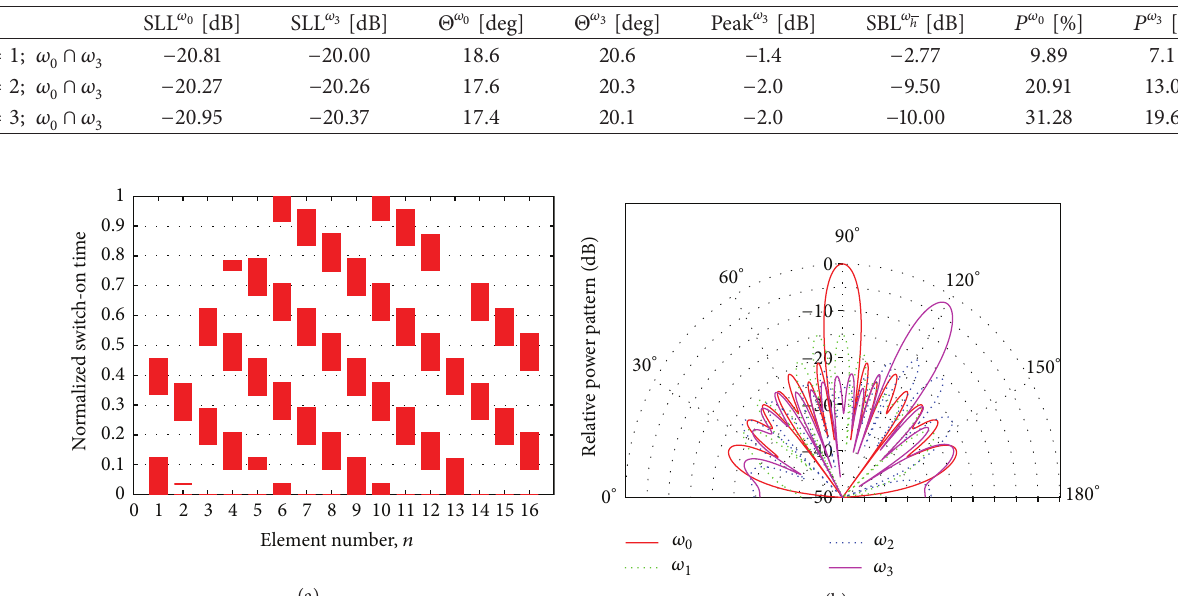
Table 2: Multibeam sum pattern synthesis at 𝜔 0 and 𝜔 3 ( 𝑁 = 16 ; 𝑑 = 𝜆/2 ; 𝜃 𝜔 0 = 90 ∘ ; 𝜃 𝜔 3 = 120 ∘ ) and pattern features for 𝑄 = 1 , 𝑄 = 2 , and 𝑄 = 3 .